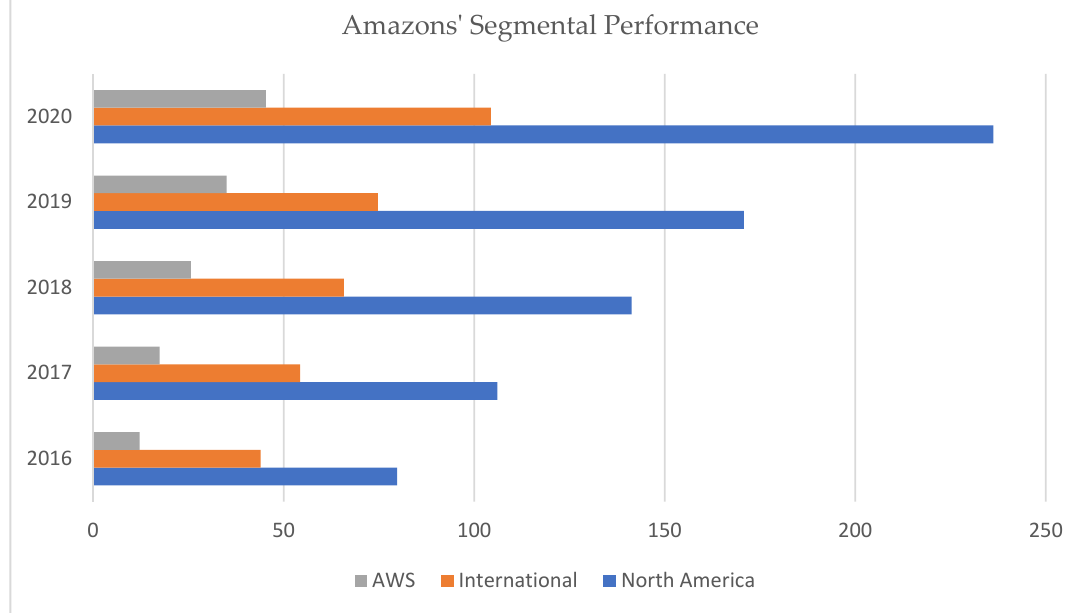
Figure 7. Walmart’s performance by segment.